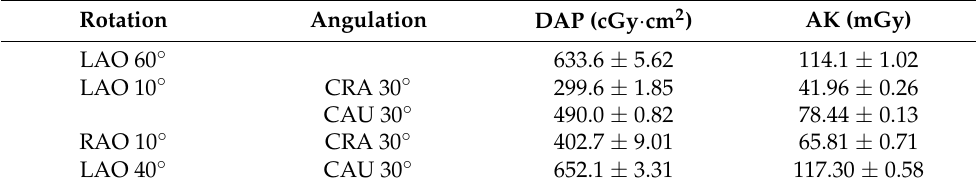
Table 4. Dose-area product (DAP) and air kerma (AK) measurements for each angle of projection. Rotation